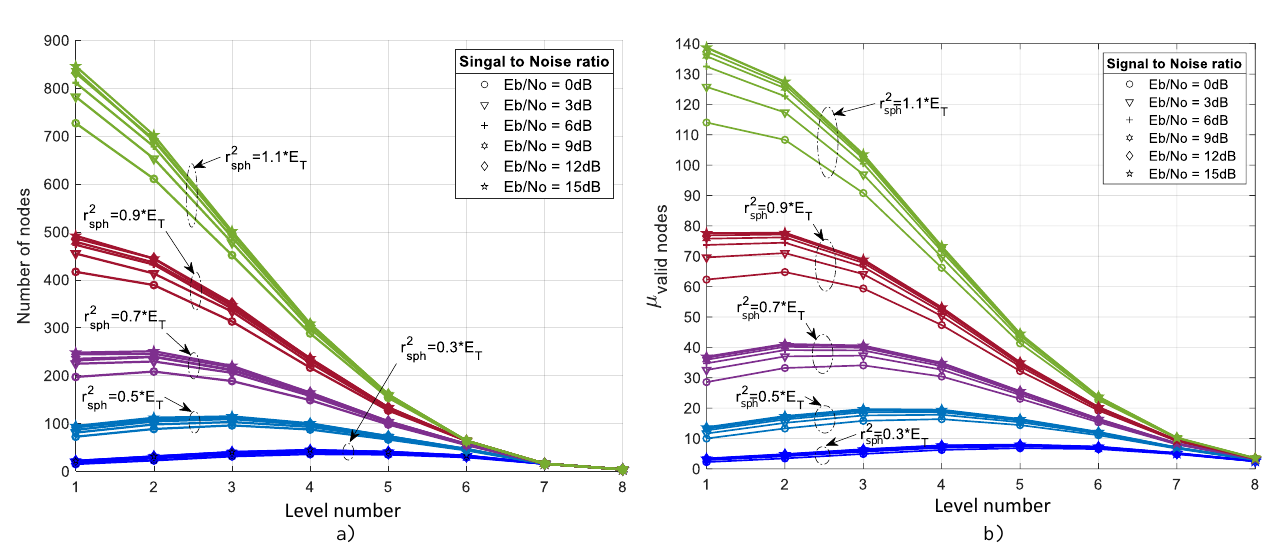
Figure 2. (a) The number of nodes corresponding to cumulative distribution of 99 . 999% coverage of all available valid node .and (b) the mean ( µ ) of valid search nodes in each level of SD search tree in 16-QAM 4 × 4 MIMO system, simulated for 1 million node random input patter with AGWN.